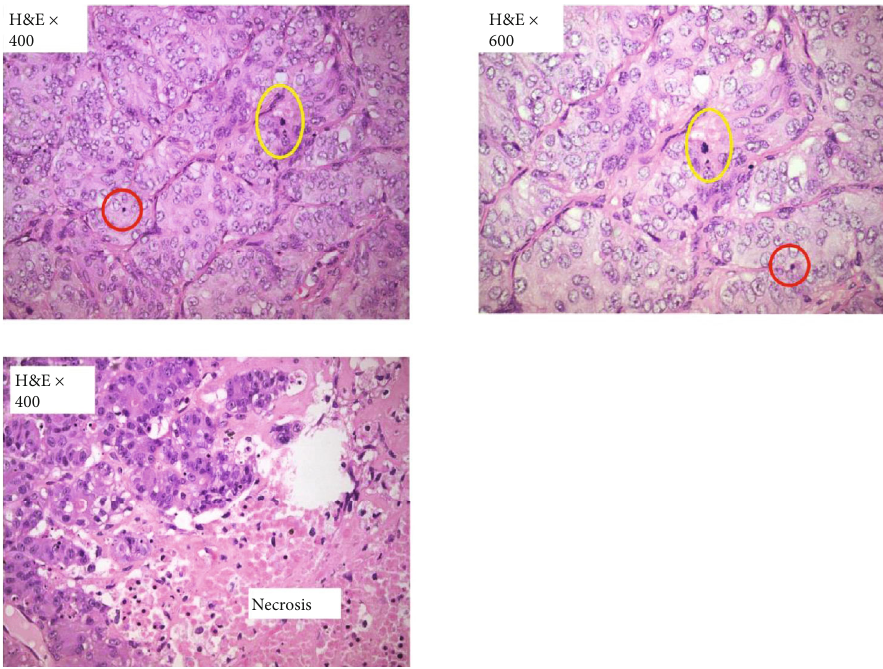
Figure 2: High-grade large cell neuroendocrine carcinoma. High mitotic (yellow circle) and apoptotic (red circle) activity. Extended necrotic